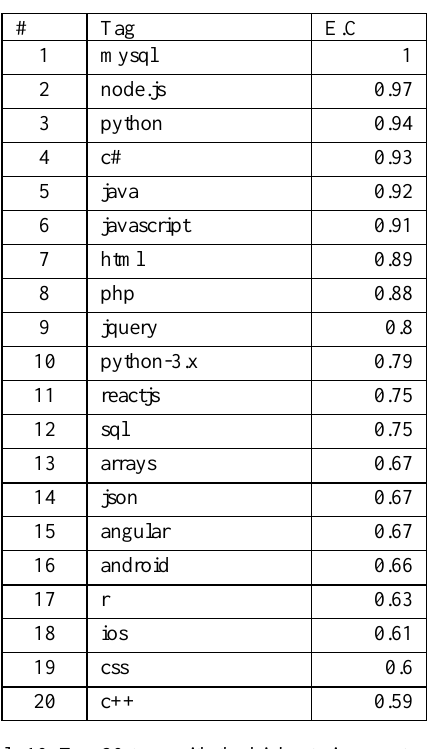
Table 10. Top 20 tags with the highest eigenvector centrality